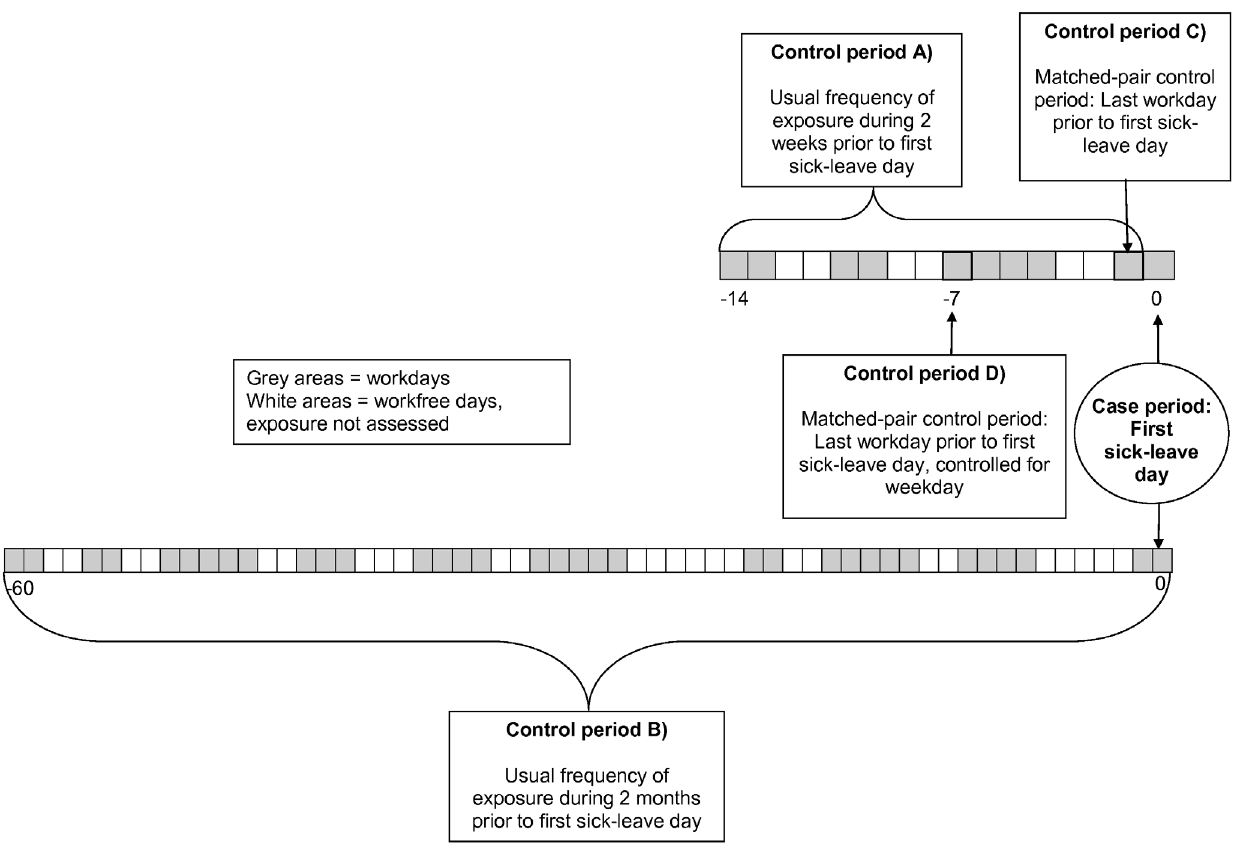
Figure 1. Description of the case and control time periods used in the analyses. The case-crossover design of the study implies analyzing exposure in different case and control time periods for the same individual. The figure describes the case period and the four alternative control periods used in the analyses.